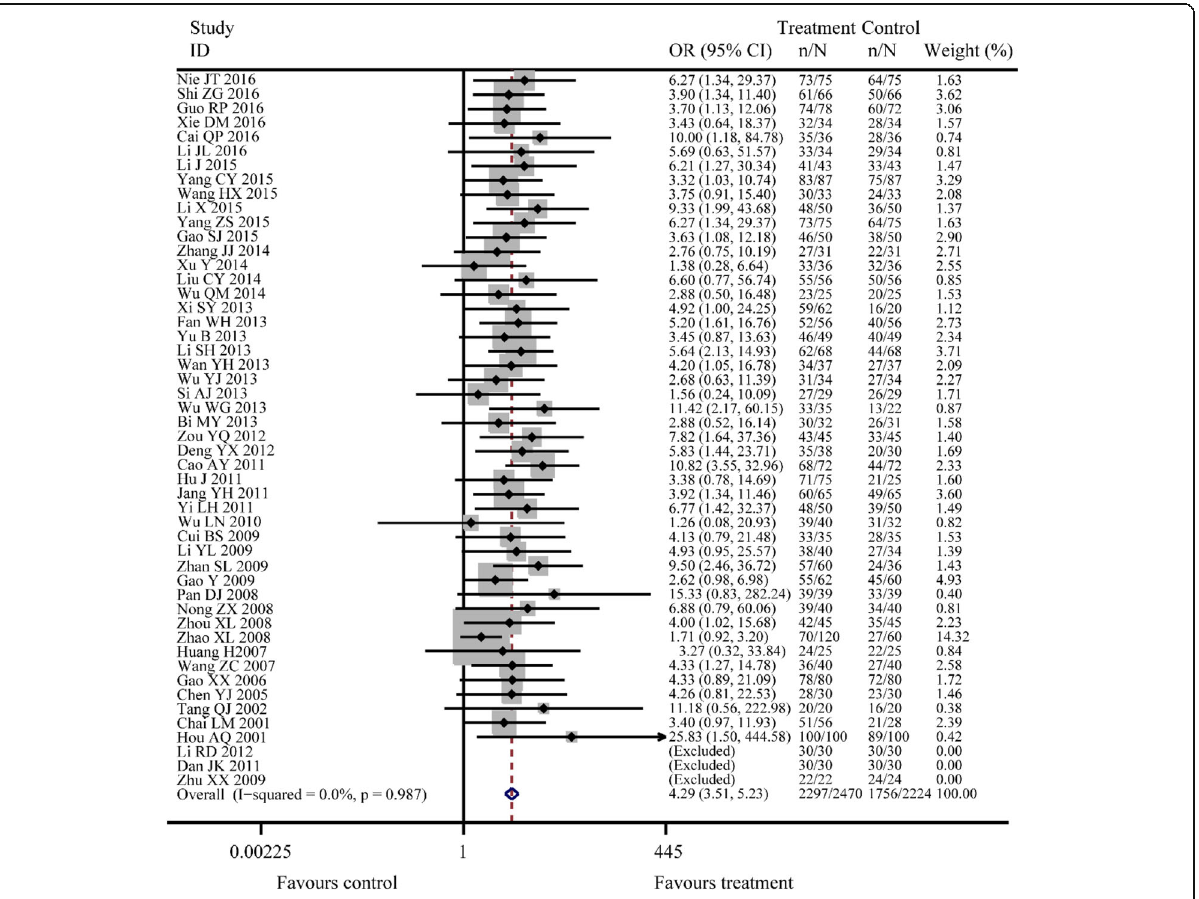
Fig. 2 Meta-analysis of total effective rates about two